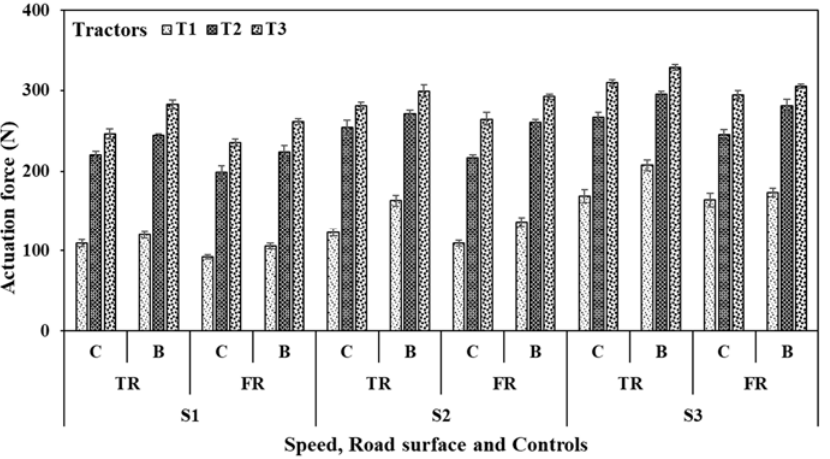
Figure 5. Actuation forces recorded during clutch and brake pedal operations of selected tractors. TR—Tarmacadam road surface, FR—Farm road surface; C—Clutch, B—Brakes. Further details are presented in Table 3.